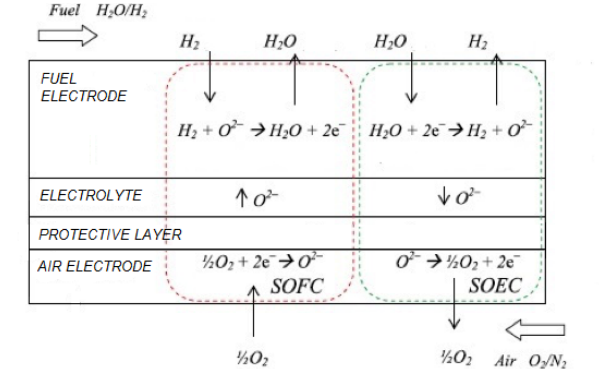
Figure 1. Schematic of a reversible solid oxide cell (ReSOC) operational modes. Adapted from [8]. SOFC: solid oxide fuel cell; SOEC: solid oxide electrolysis